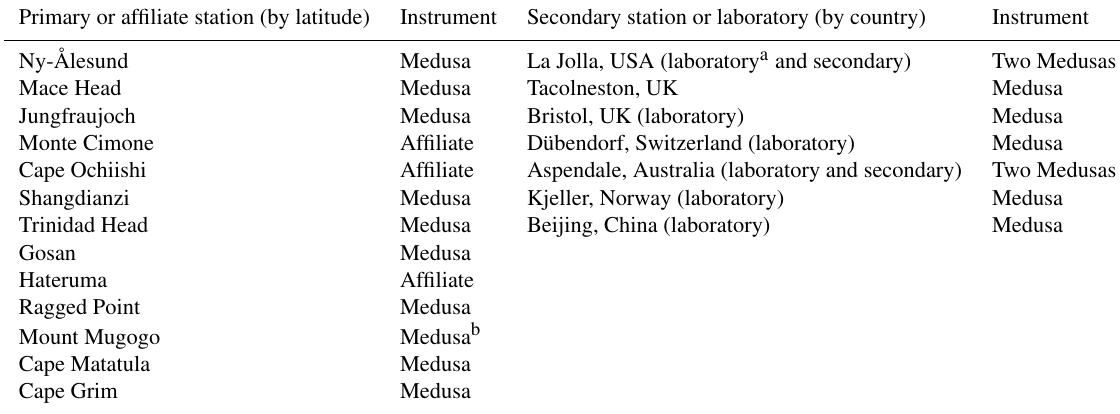
Table 3. GC-MS instruments at AGAGE primary, affiliate, and secondary monitoring stations and at laboratories. Primary or affiliate station (by latitude)